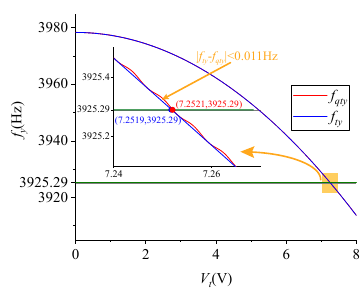
Figure 6. The effect of V t and V q on f y .